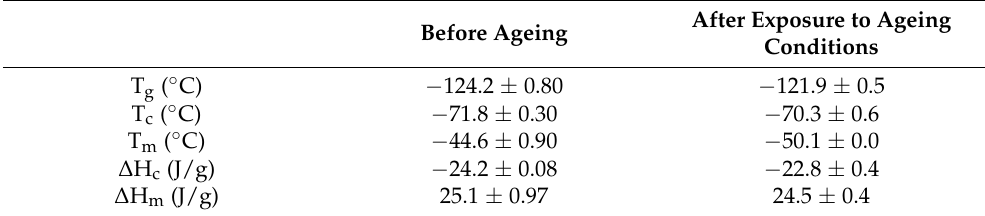
Table 8. DSC results of 2 wt% TiO 2 /PDMS nanocomposite after 258 h exposure to accelerated aging, in comparison with unexposed (reference) specimens.